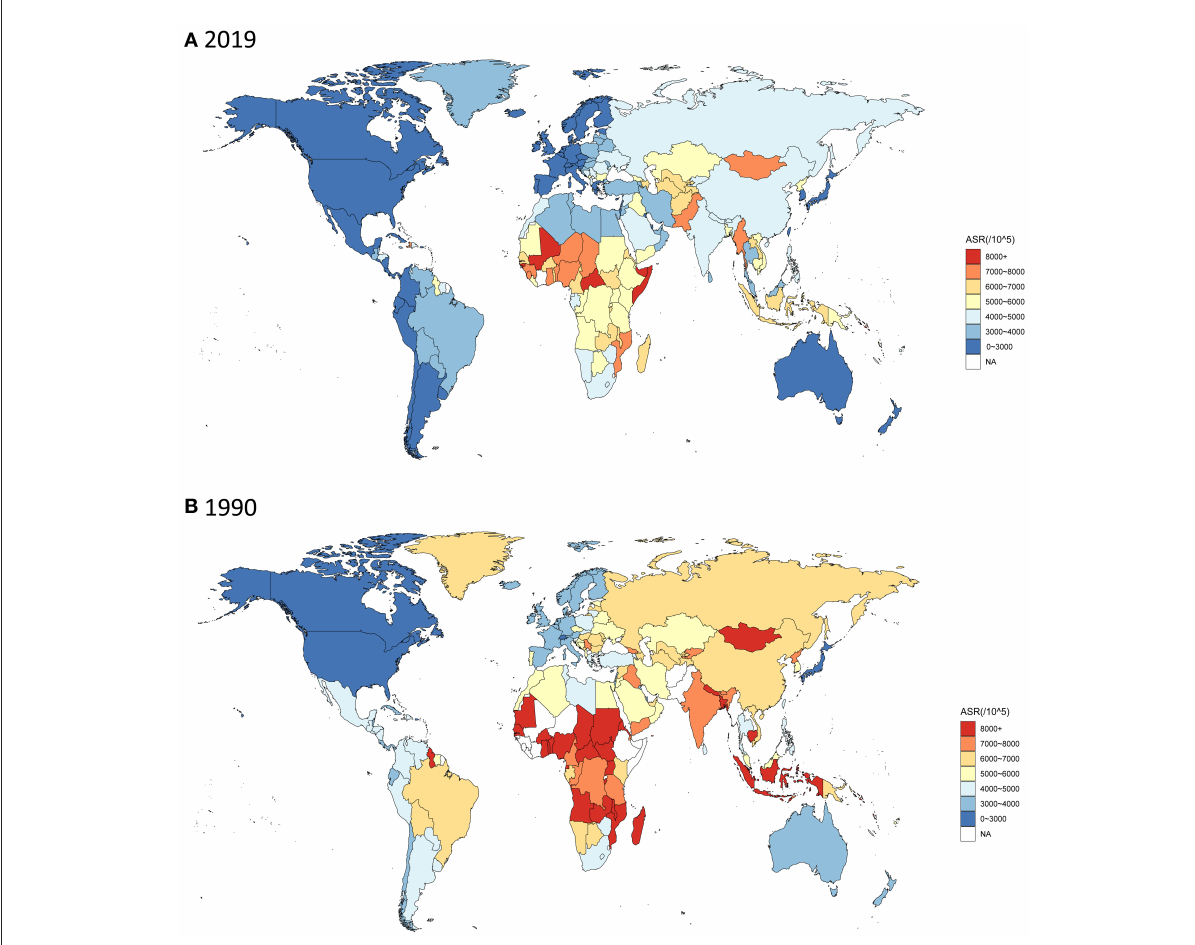
FIGURE2 Age-standardized DALY rates of neurological disorders for all ages and both sexes among 204 countries and territories. (A) in 2019; (B) in 1990.